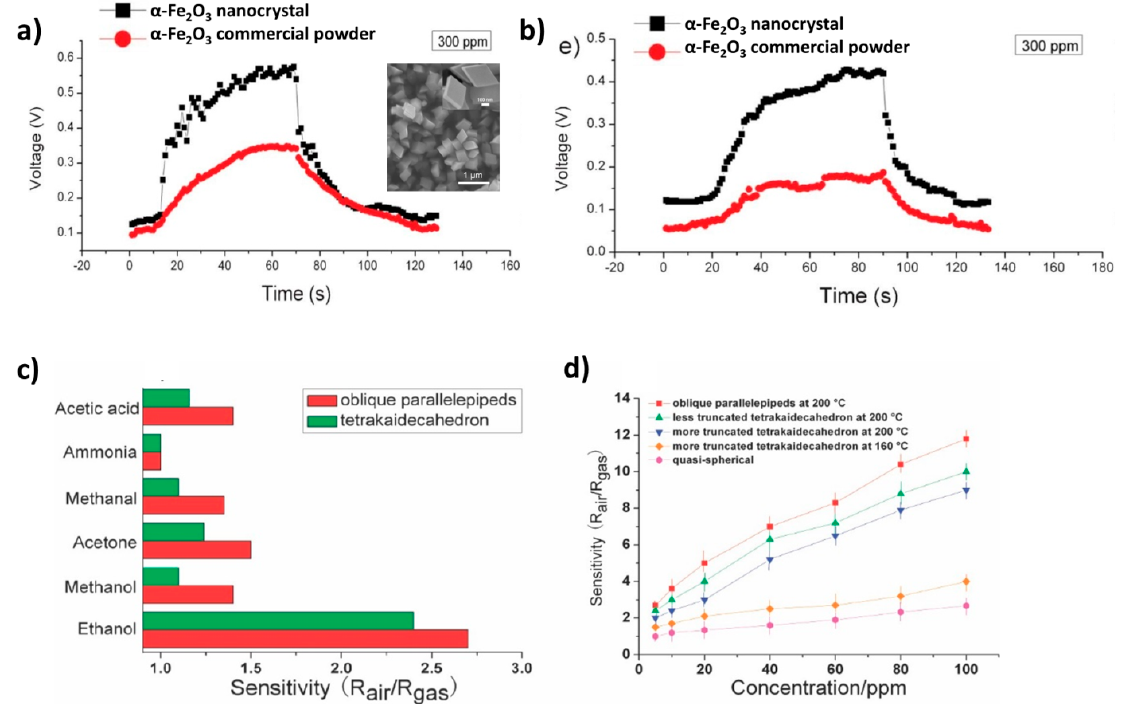
Figure 10. Dynamic response–recovery curves for acetone ( a ) and ethanol ( b ) detection (300 ppm). Reprinted and modified with permission from ref. [134] Sensitivity of the sensors based on as-prepared hematite towards different gases or vapors at a concentration of 5 ppm ( c ). Sensitivity curves of hematite particles with different shapes as a function of ethanol concentration ( d ). Reprinted and modified with permission from ref. [34].